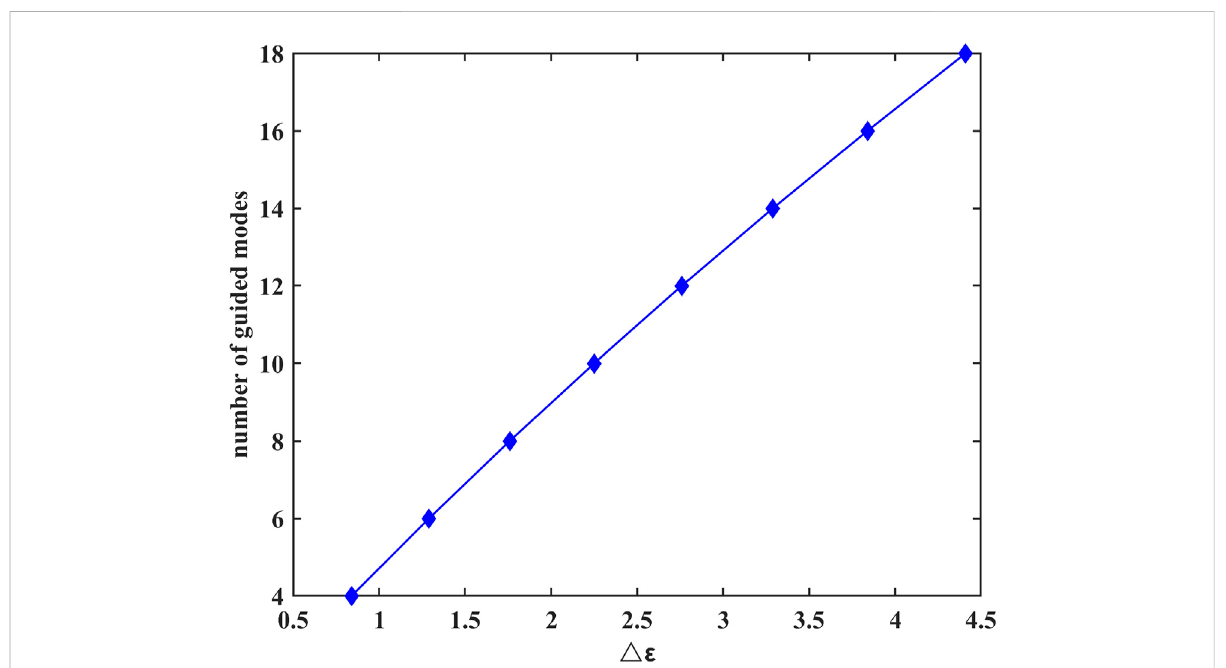
FIGURE 4 Difference between the dielectric constant of the myelin sheath and internal fl uid on the number of guided modes at f = 30 THz.